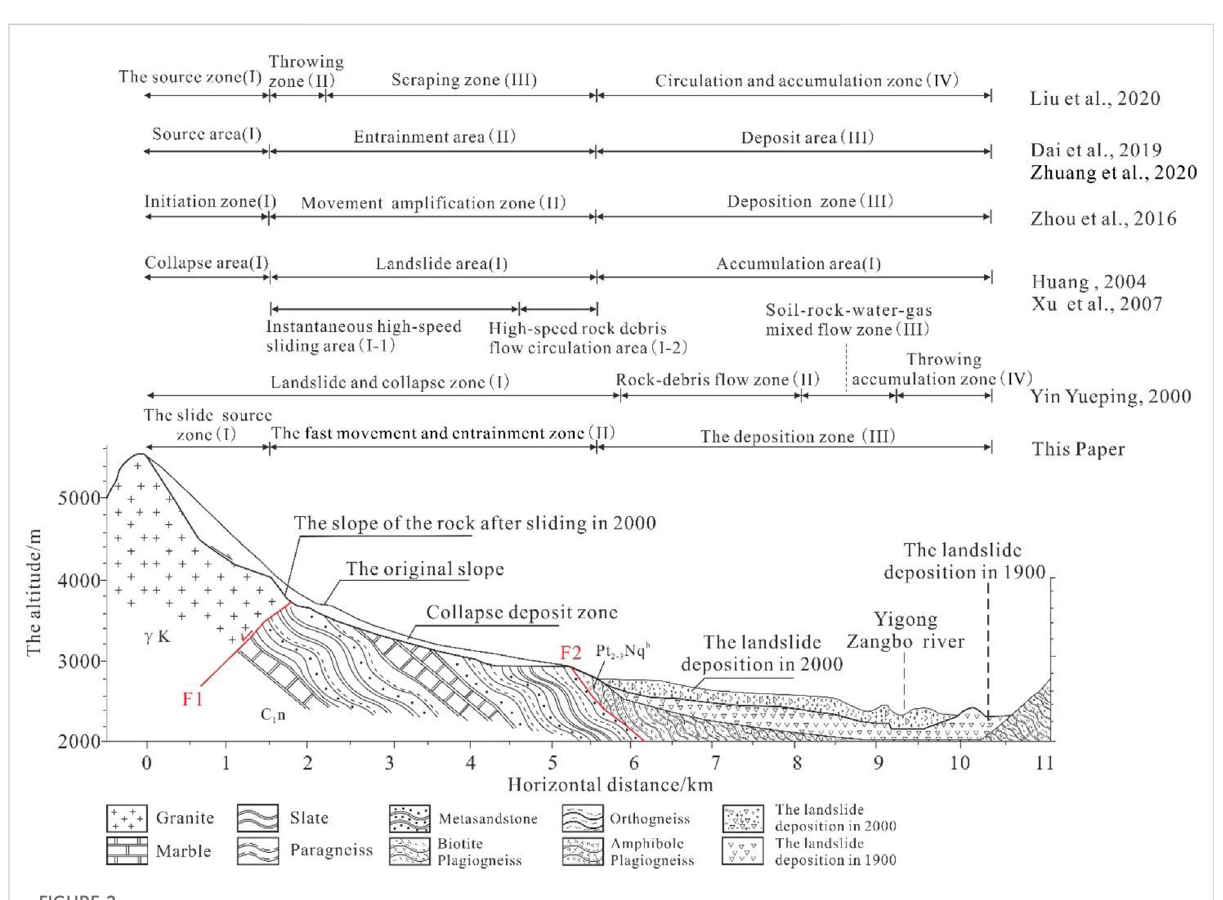
FIGURE 2 CharacteristicsofspatialdistributionofYigonglandslidein2000(Geologicalpro fi leismodi fi edafterYin,2000;Xuetal.,2012;F1 — Dade-Anizha Fault, F2 — Jiali